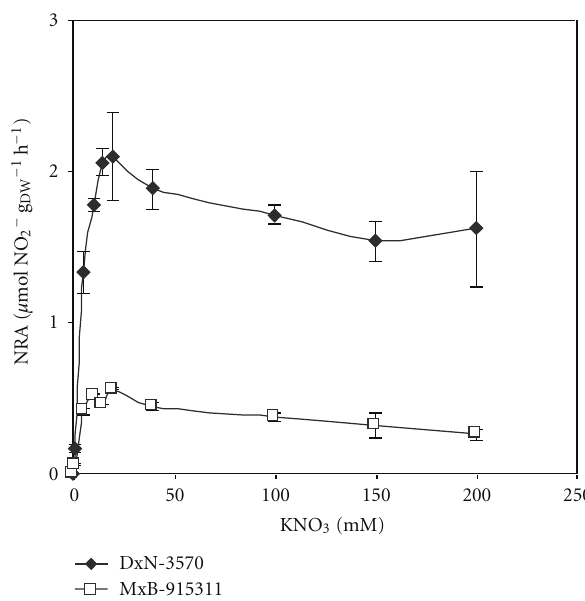
Figure 2: E ff ect of substrate concentration on nitrate reductase activity (NRA) of clone DxN-3570 and clone MxB-915311. All data points are means of duplicate samples and vertical bars represent SD of the means.